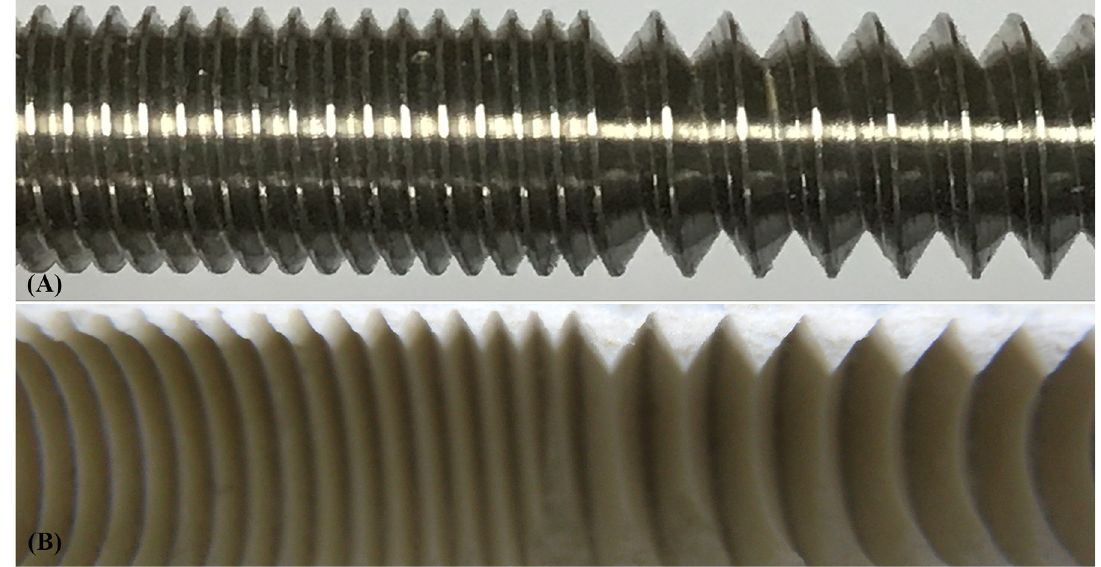
Fig 7. Photographs showing the (A) actual DC/DT screw; and (B) inner thread profile of the test block following insertion and removal of the DC/DT screw. The integral thread profile showed no damage in the test block, demonstrating no interference at the bone-screw interface during screw insertion and